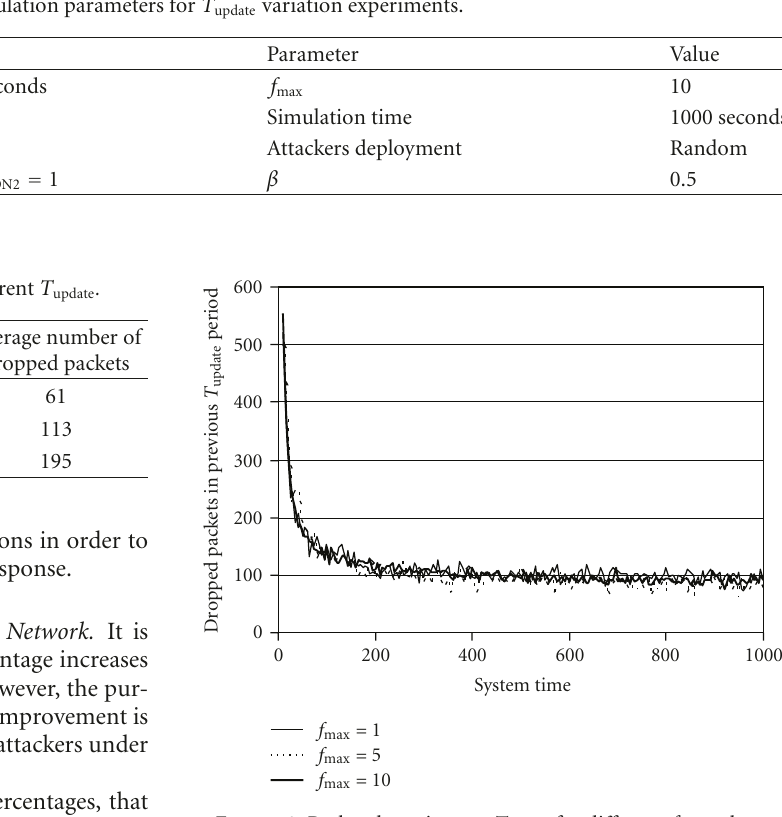
Figure 8: Packet dropping per T update for di ff erent f max